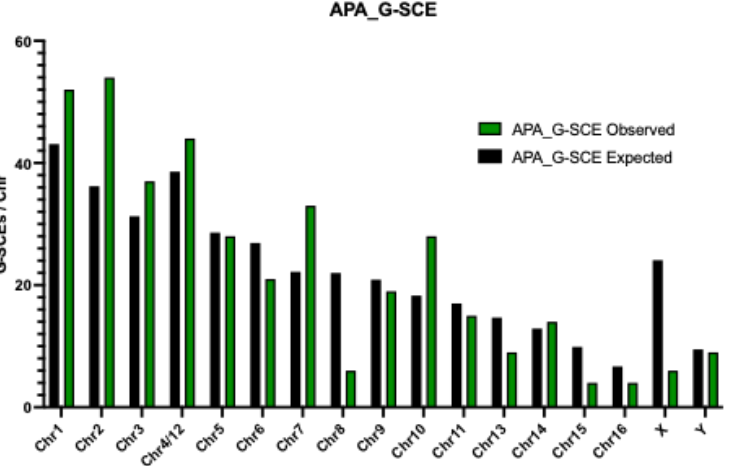
Figure 3. G-SCEs A. chamek and A. paniscus . Examples of chromosome pairs involved in evolution- ary rearrangements for the genus. ( a ) chromosome pairs 1, 2, 3, 4, 5, 6, and 7 in A. chamek ; and ( b ) chromosome pairs 1, 2, 3, 4/12, 7, and 10 in A. paniscus .